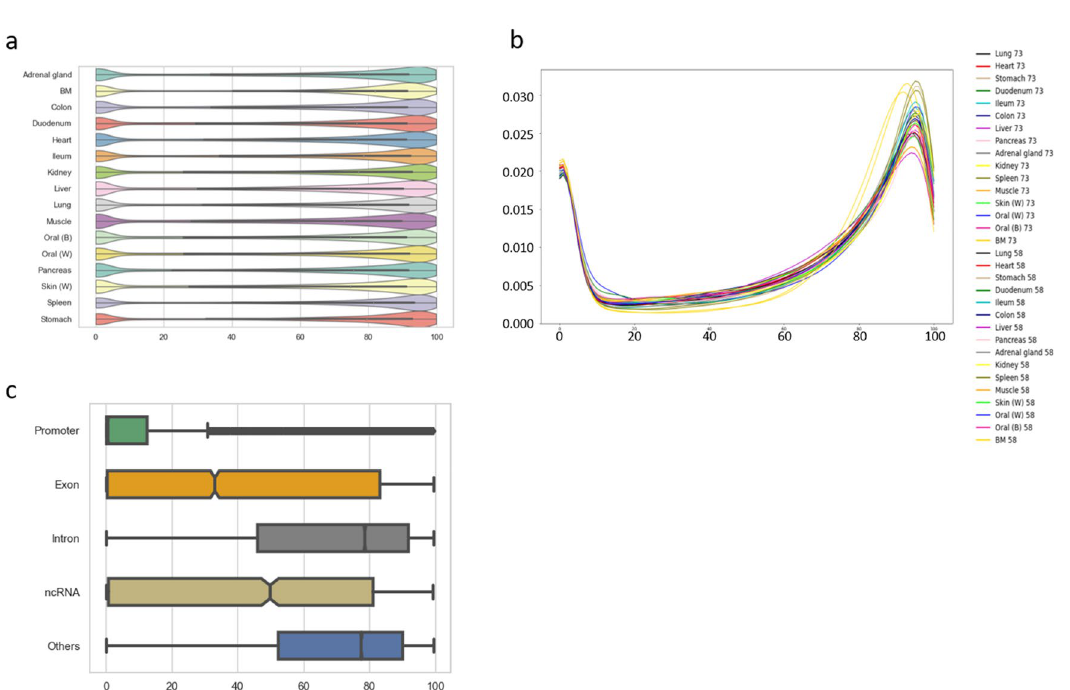
Figure 2. Characterization of DNA methylation patterns across cell types. ( a ) Violin plots of genome-wide DNA methylation levels of all CpG sites for each of the 16 methylome after averaging values for the same tissues. ( b ) Density plots of genome-wide DNA methylation levels of all CpG sites for each of the 32 methylomes. ( c ) DNA methylation level of CpG sites classified by the genomic feature. DNA methylation levels of 6416, 9002, 55,065, 2388, and 57,990 CpG sites at promoters, exons, introns, ncRNA, and other regions, respectively, were calculated first, then averaged for all cell types used in this study. The boxes signify upper and lower quartiles while the median is represented by vertical lines within the boxes. Whiskers indicate maximum and minimum values except for outliers that are shown outside of whiskers. All figures are depicted by seaborn (https:// doi. org/ 10. 5281/ zenodo. DNA methylation level correlated with gene expression. DNA methylation at promoter is known to correlates with gene expression silencing 4 . Of 130,861 CpG sites, 6416 (4.9%) sites were located closely at pro- moter region of genes, which corresponded to 7517 transcripts. We obtained RNA-seq data of the same samples and integrated available gene expression data to observe correlation between differential gene expression and DNA methylation. As a result, we could utilize 3783 CpG sites that were located at promoter region of these tran- scripts. We plotted differential expression and methylation levels between each pair of all samples after averaging anatomically similar tissues (stomach, duodenum, ileum, and colon were combined intro GI tract. Likewise,